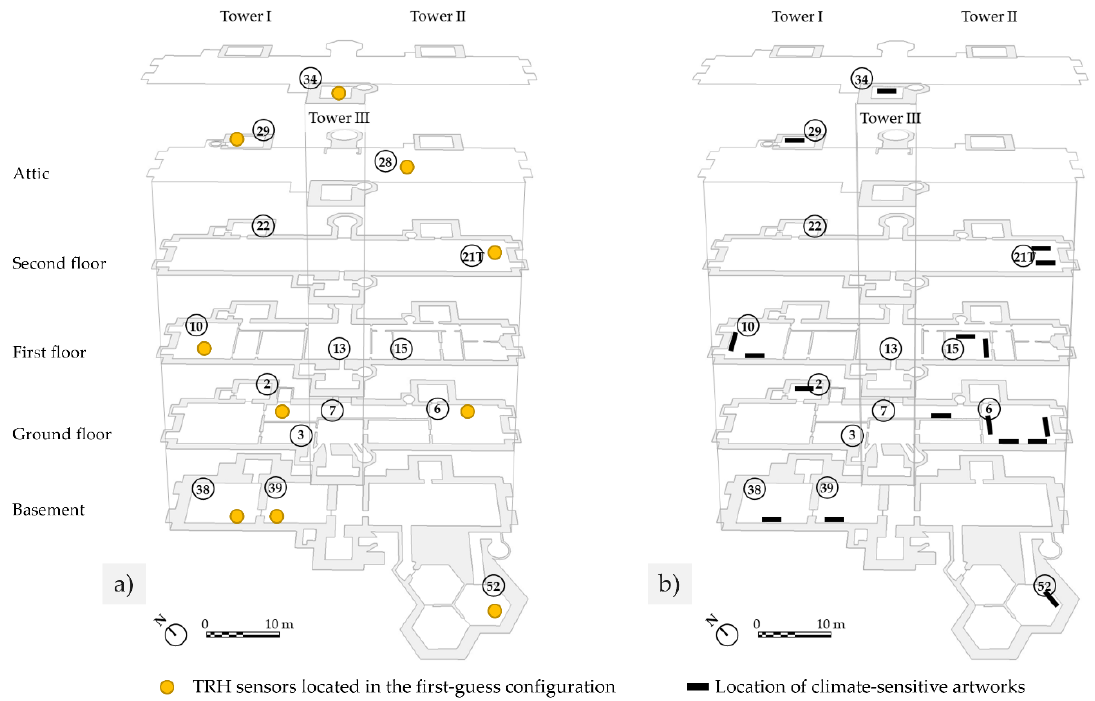
Figure 2. Plans of Rosenborg Castle: ( a ) First-guess configuration of the TRH sensors (yellow circles). ( b ) Location of those artworks (black parallelepipeds) which were selected by museum conservators in the framework of the CollectionCare project. Room numbers are provided in the circles and also correspond to the associated TRH